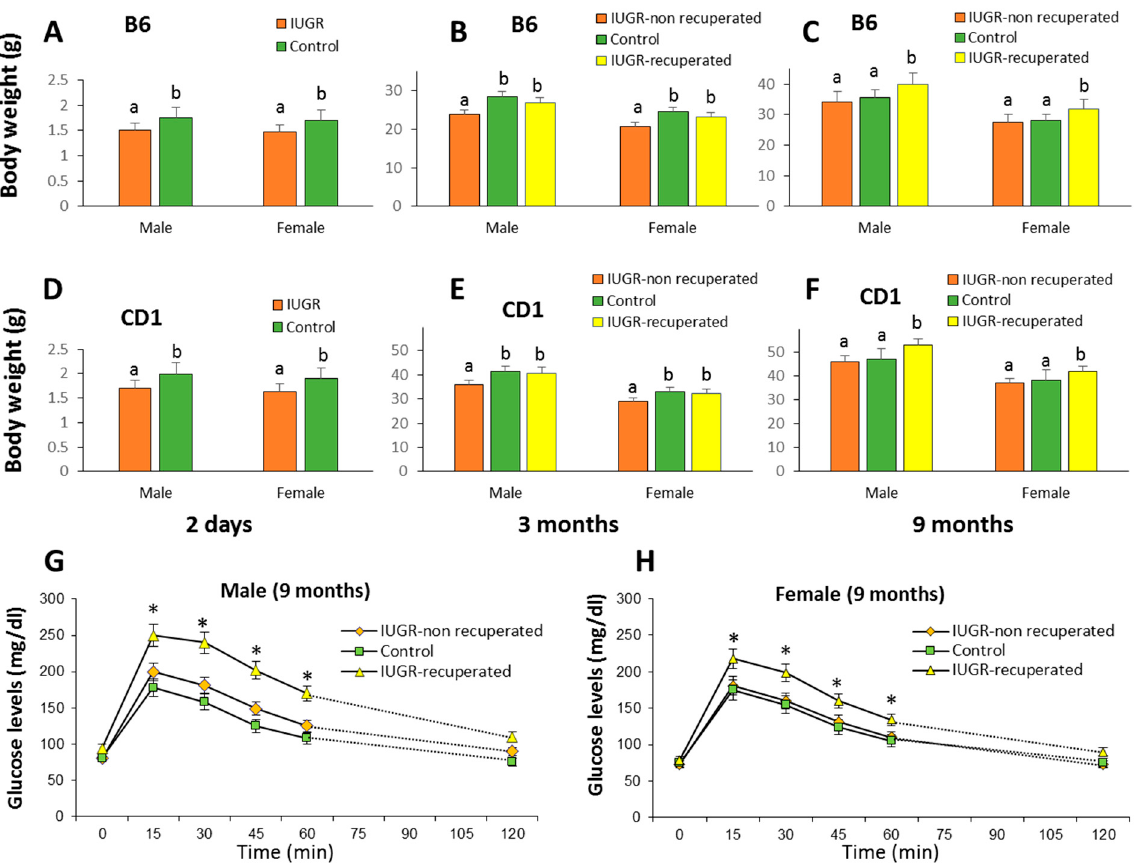
Figure 1. Weights and glucose tolerance of the mice used in this study. Weight at 2 days of age is indicated in B6 ( A ) and CD1 ( D ) mice with IUGR and controls of both sexes. Also indicated are weights at 3 months of age of the B6 ( B ) and CD1 ( E ) mice, and at 9 months of age of the B6 ( C ) and CD1 ( F ) mice. Weights are provided for all animals with IUGR, without IUGR (controls) and those with IUGR that at three months showed a similar weight to controls (IUGR-recuperated). Glucose tolerance test (1.5 g glucose/kg body weight, intraperitoneal) in unrestrained 9-month-old male ( G ) and female ( H ) mice after an overnight fast (n = 7 per group). Blood glucose measurements were taken every 15 min for 120 min with a blood glucose monitor (Accu-Chek). Symptoms of metabolic syndrome (glucose intolerance) were observed in IUGR-recuperated mice but not in the IUGR non-recuperated mice. Results provided as the mean ± SD. a,b different letters indicate significant differences ( p < 0.05). *, “ p < 0.05” versus control mice.